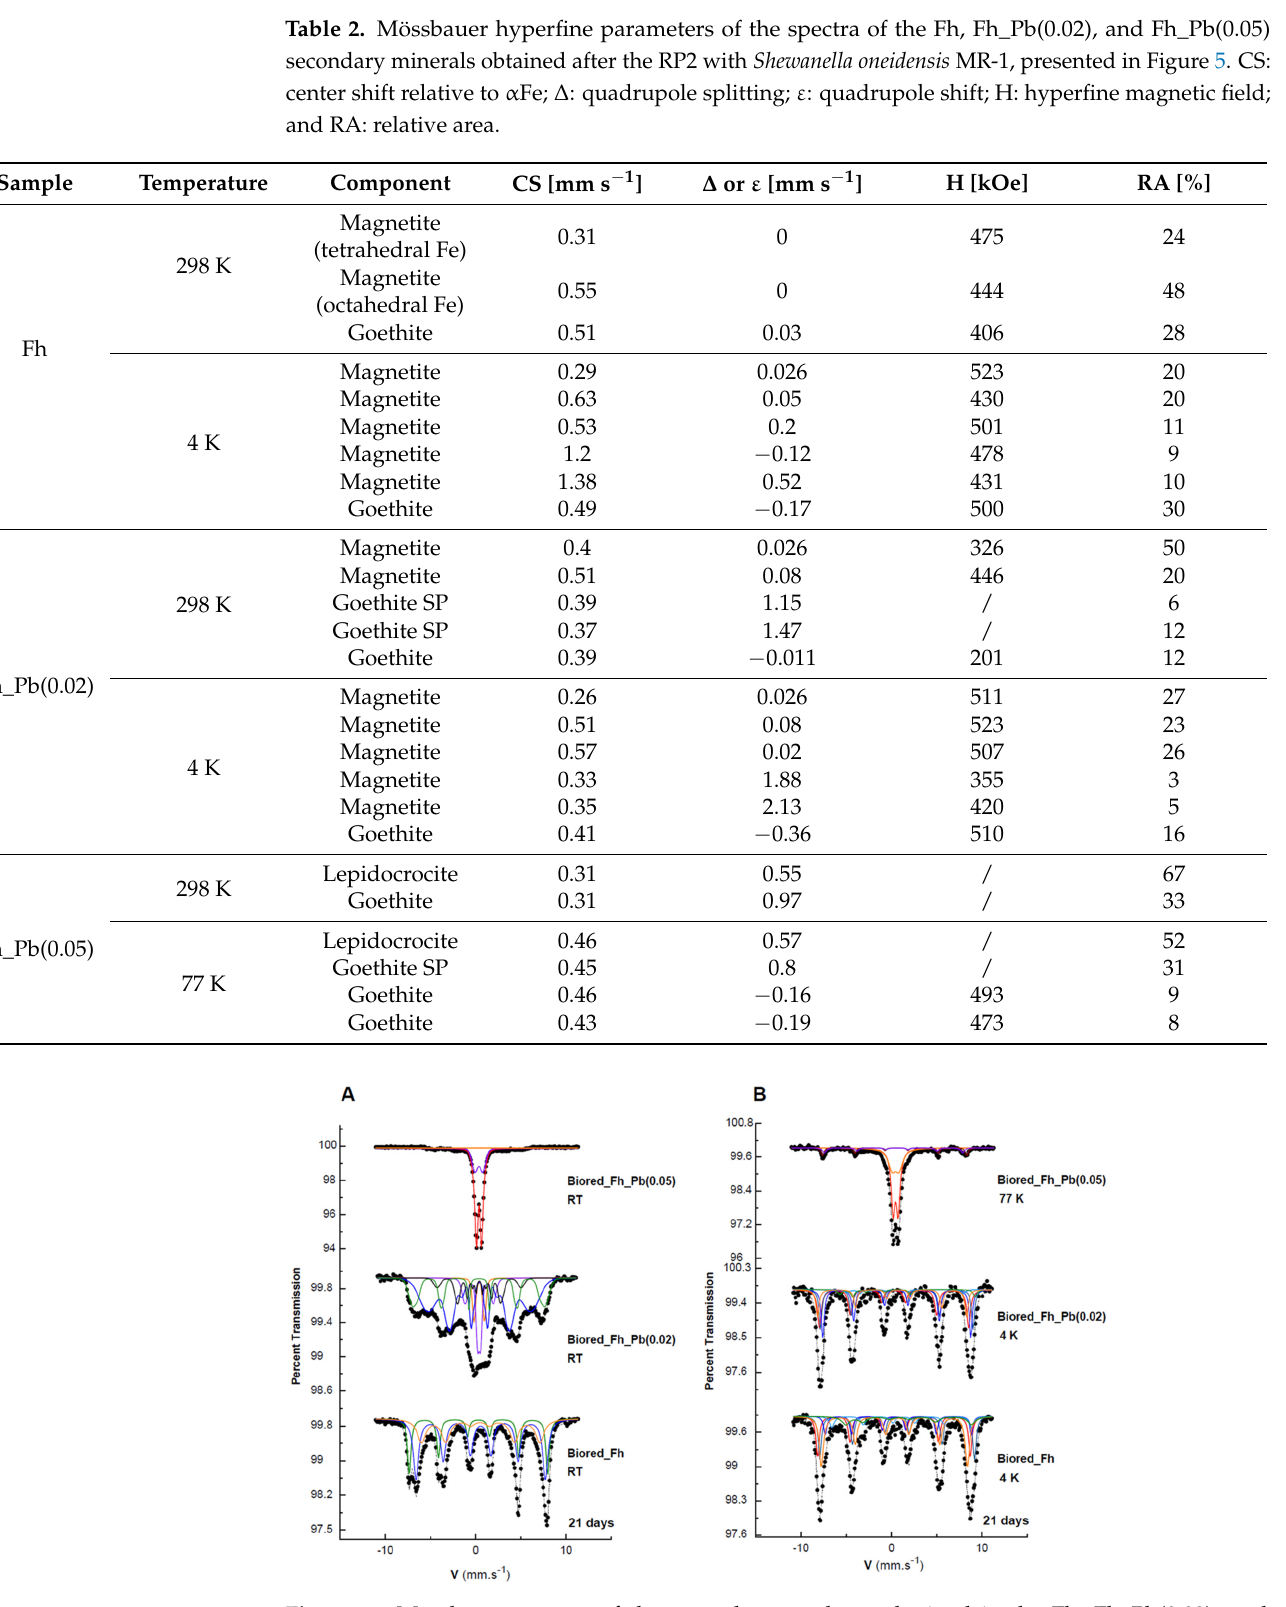
Figure 5. Mössbauer spectra of the secondary products obtained in the Fh, Fh_Pb(0.02), and Fh_Pb(0.05) systems at: ( A ) room temperature (RT), and ( B ) 77 or 4 K after the RP2 with Shewanella oneidensis MR-1. Hyperfine parameters corresponding to these spectra are presented in Table 2. Table 2. Mössbauer hyperfine parameters of the spectra of the Fh, Fh_Pb(0.02), and Fh_Pb(0.05) secondary minerals obtained after the RP2 with Shewanella oneidensis MR-1, presented in Figure 5. CS: center shift relative to α Fe; Δ : quadrupole splitting; ε : quadrupole shift; H: hyperfine magnetic field; and RA: relative area.